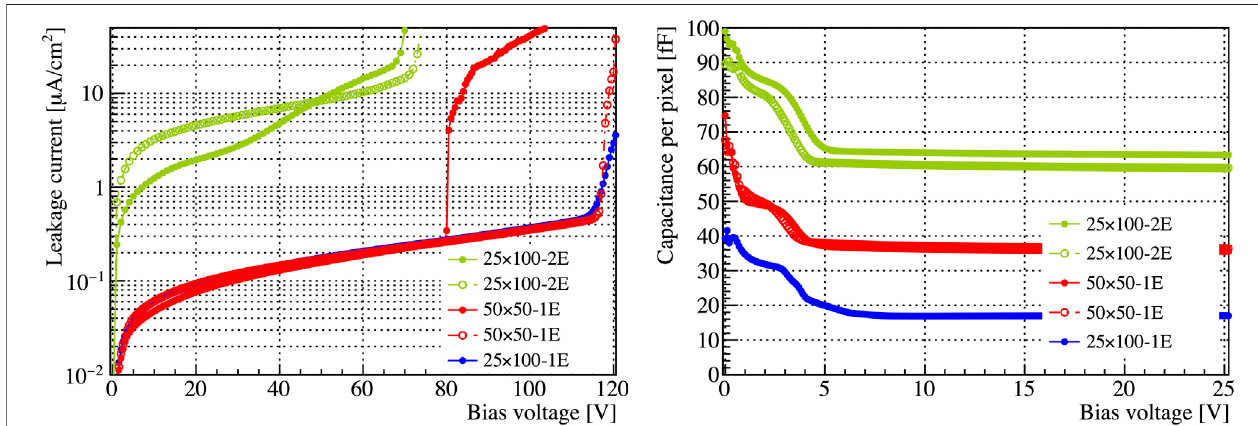
FIGURE4| CNM3Ddiodemeasurementsperformedonwaferattheendoftheprocessonthe fi nalmetal.I-V (left) andC-V (right) curvesareshown.Asystematic uncertainty, not shown in the fi gures, of less than 10%has been estimated for both current and capacitance measurements, due totemperature variations and the LCR circuit, respectively. The systematic uncertainties due to the test instrument for the considered voltage and current range are smaller than 1%.